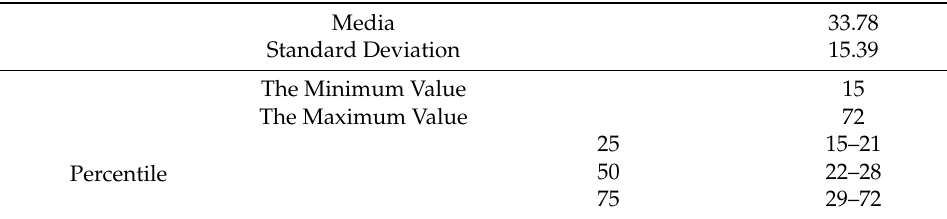
Table 8. The indicative standard for